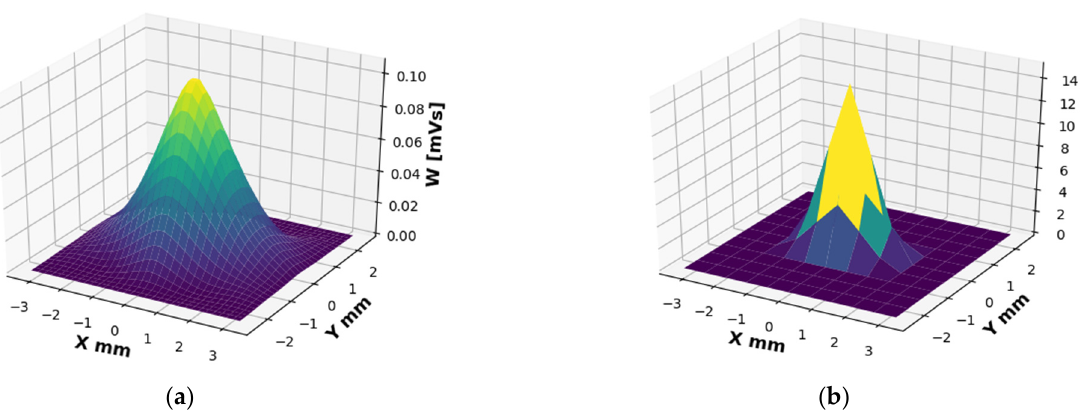
Figure 7. WDF from the entire aperture, only with rays propagating parallel to the z -axis, W x ( k x = 0, k y = 0). ( a ) Of the radiation field at 2.89 [THz]. ( b ) Of the window function.